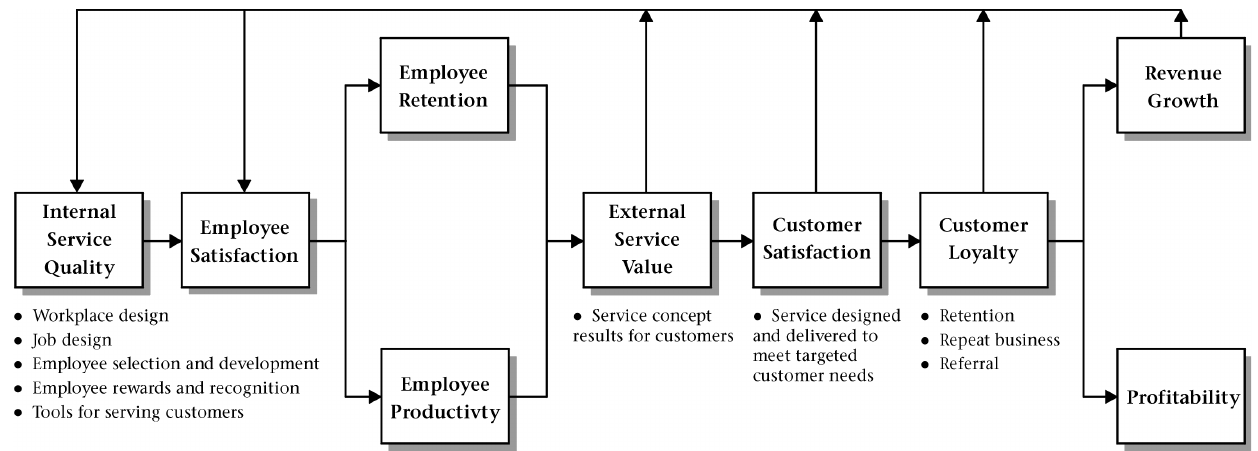
Figure 1: Service-profit